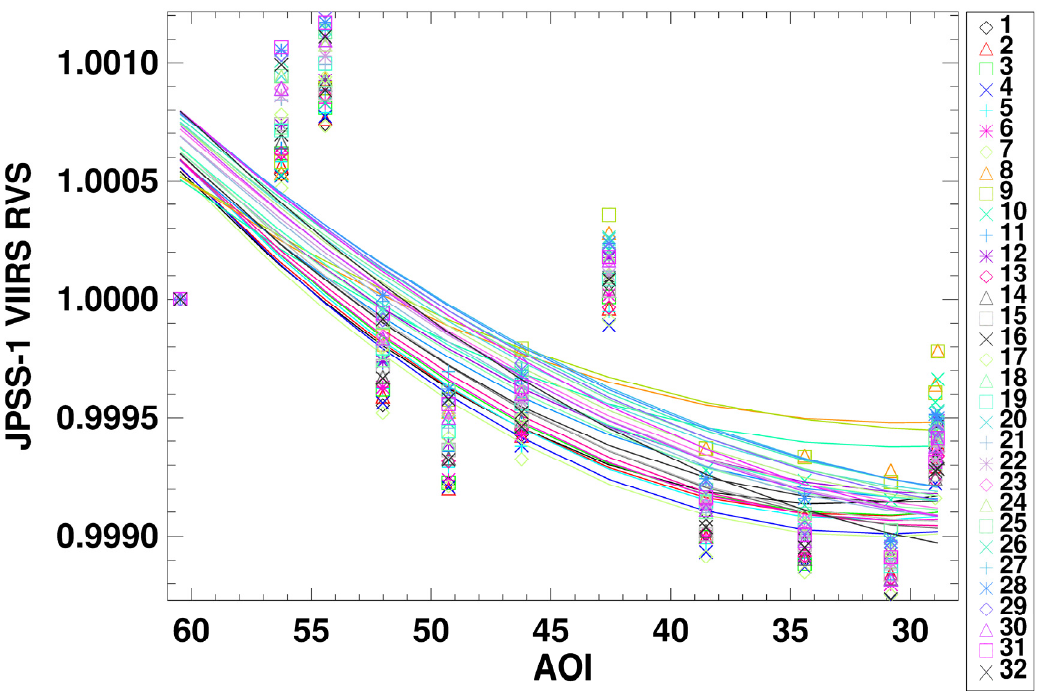
Figure 5. Band I2 HAM side A RVS and Fits for all Detectors.